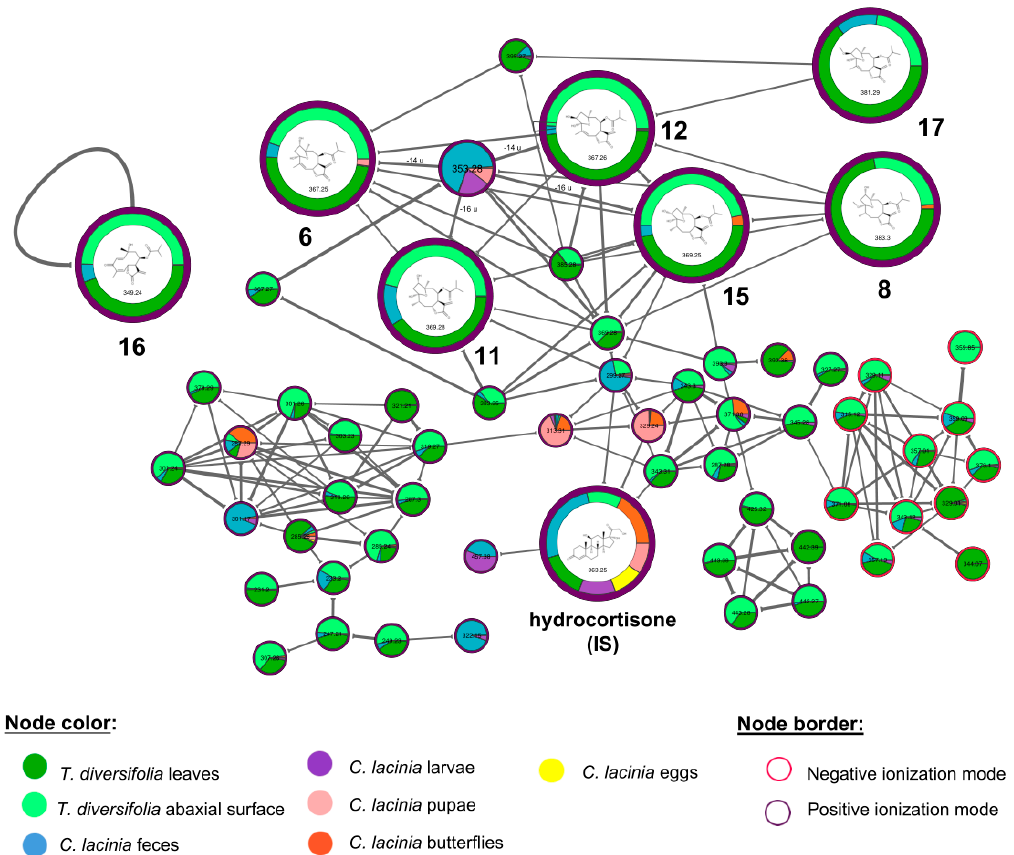
Figure 3. Molecular networking highlighting the cluster of annotated sesquiterpene lactones. Nodes are colored according to the type of sample. Borders of the nodes are colored according to the ionization mode in which the mass feature was obtained. IS, internal standard.